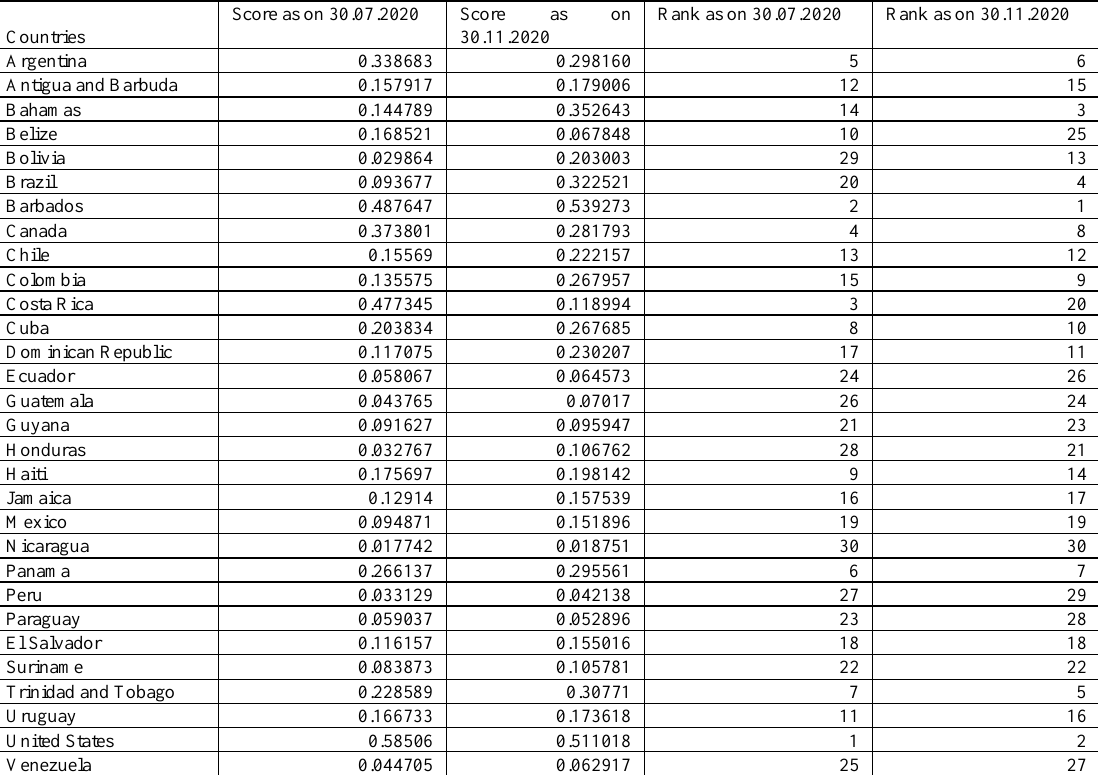
Table 5. Performance Scores and Corresponding Ranks of the nations as on 30 th July, 2020 and 30 th